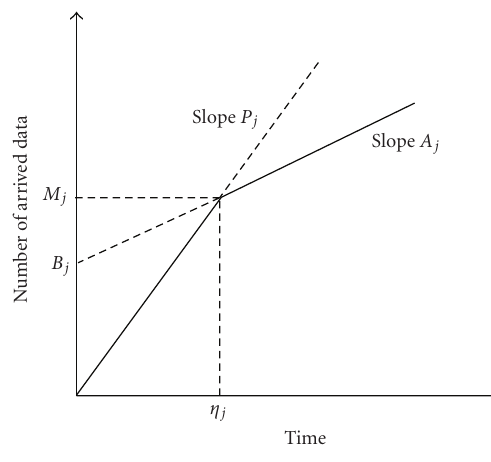
Figure 3: The tra ffi c envelop for a tra ffi c flow with the DTB shaper.